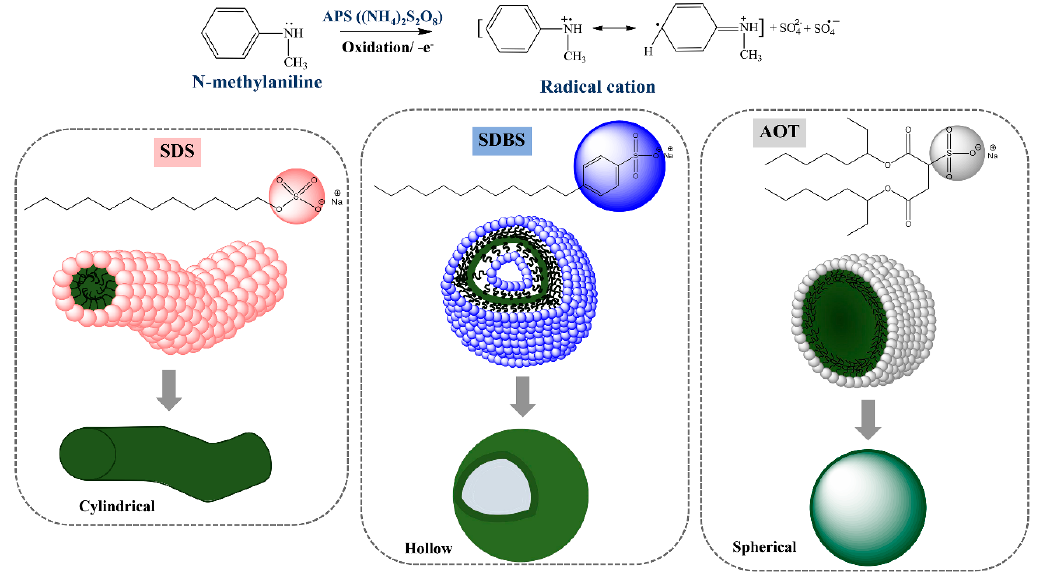
Scheme 2. Proposed micelle formations of different surfactants.